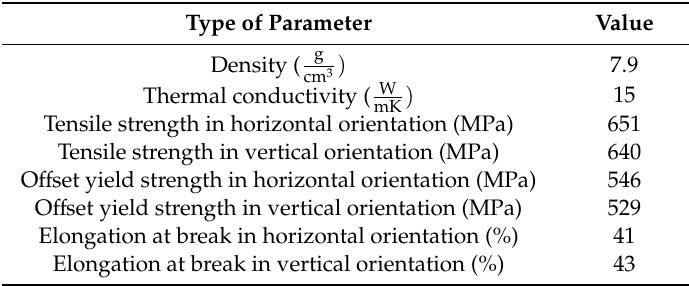
Table 2. Physical and mechanical properties of SLM-processed 316L stainless